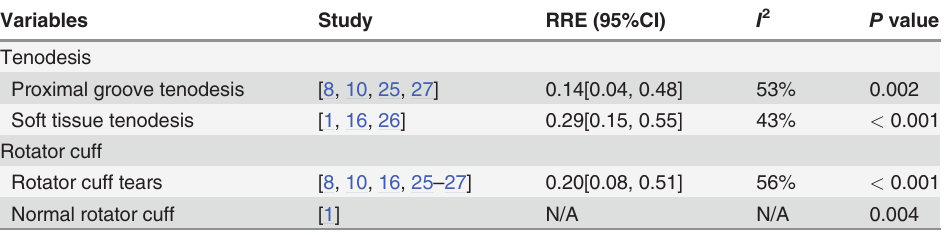
Abbreviations : RRE, risk ratio effect; N/A, not